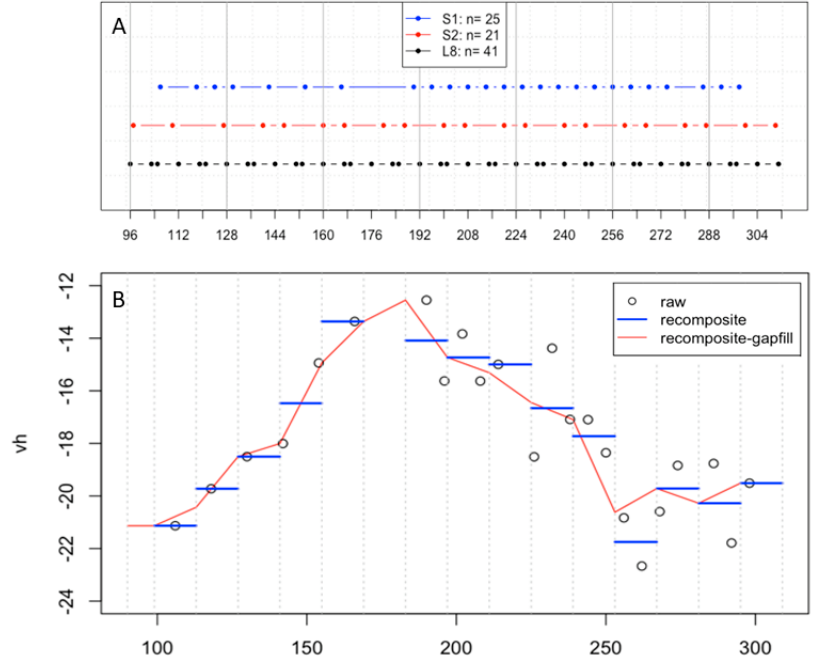
Figure 3. An example ( A ) time-frequency collected by sensor type across the northeast Arkansas (NEA) case study region. An example ( B ) multitemporal time series routine post processing Sentinel-1 VH observations a single corn pixel from NEA. Open circles (raw) give the VH backscatter γ ° from the original image overpass date (2016). Blue lines (recomposite) are the mean value for each 15-day window shown by the vertical gray dotted lines, and the red line illustrates the final smoothed/interpolated classification inputs.